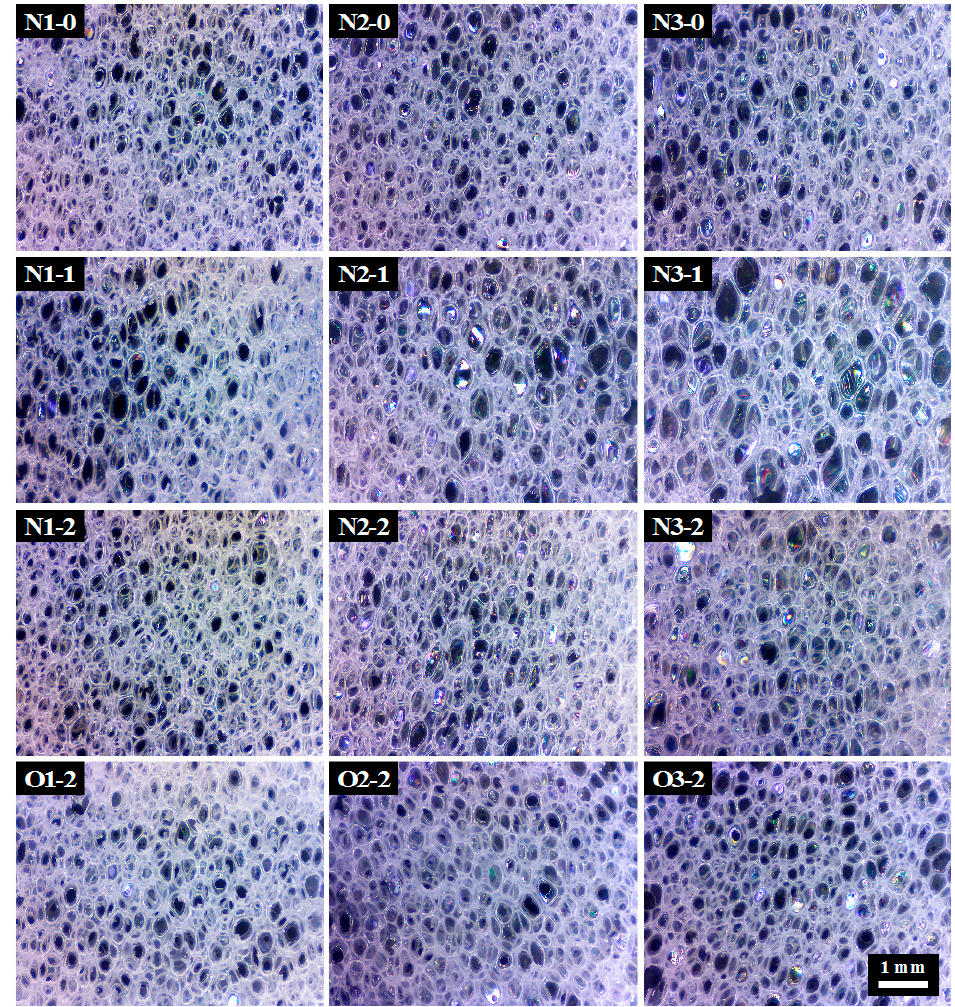
Figure 4. Pore micrographs of PU foams. All scale bars of subfigures are the same as O3-2.